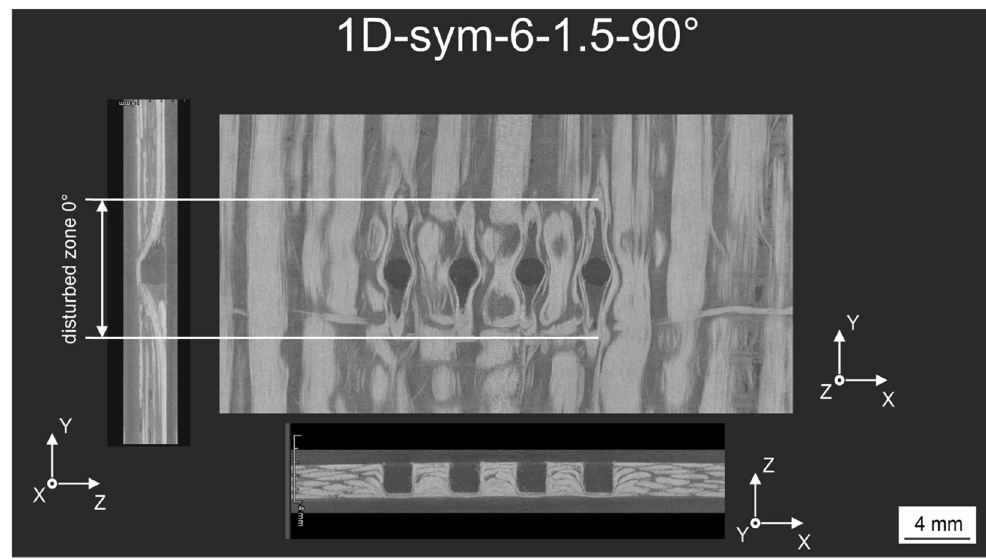
Figure 8: Example of 1D pin array with 90° array